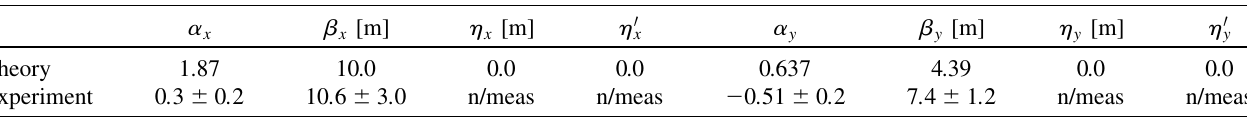
TABLE III. The theoretical and measured beam parameters at the beginning of the NSRL beam-transport line. (‘‘n/meas’’ is ‘‘not measured.’’)